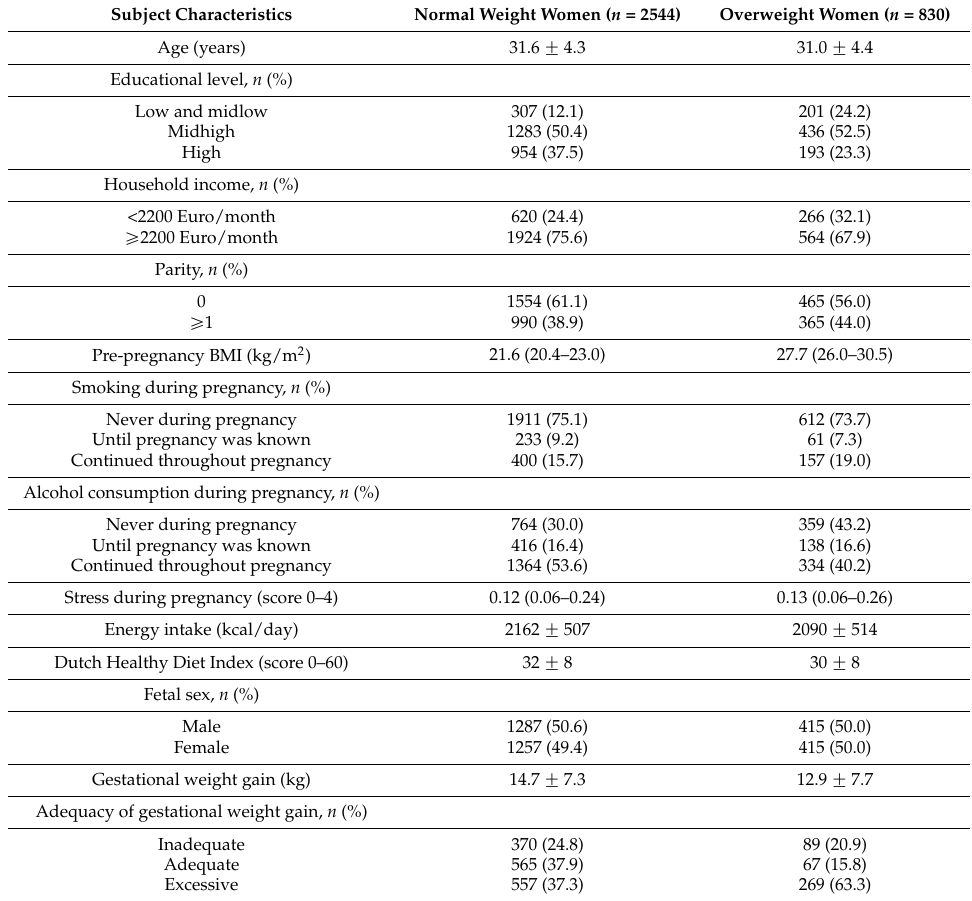
Table 2. Subject characteristics ( n = 3374), the Generation R Study (2002–2006) 1